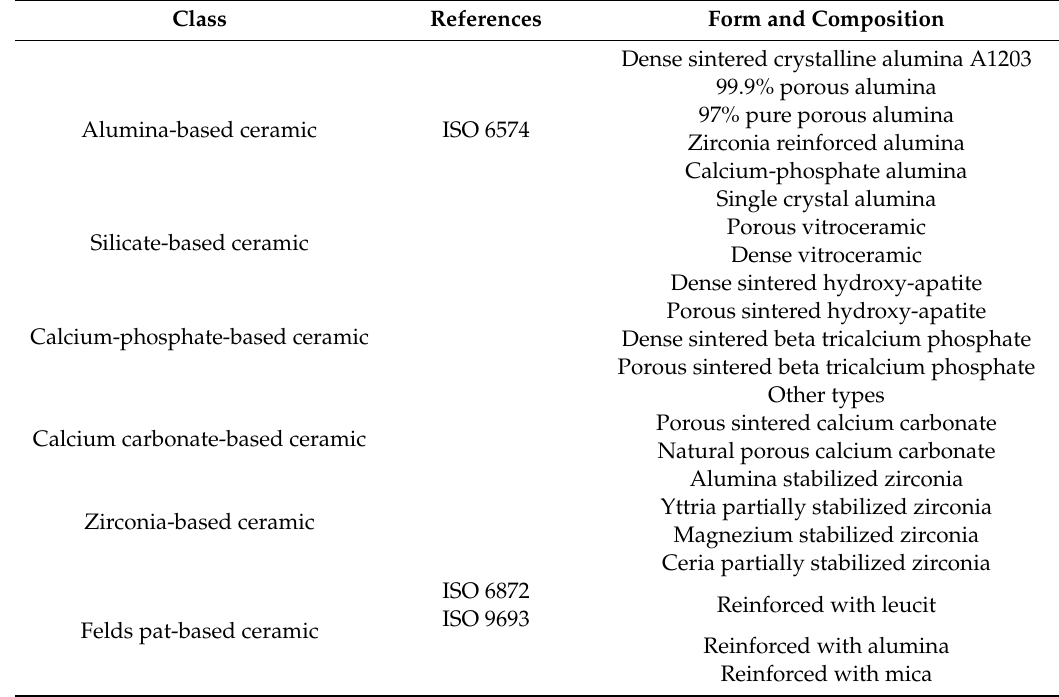
Table 1. Types of ceramics for medical